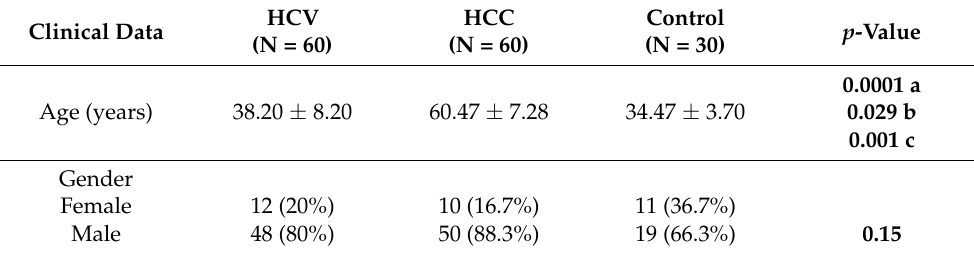
Table 1. Demographic data of the studied